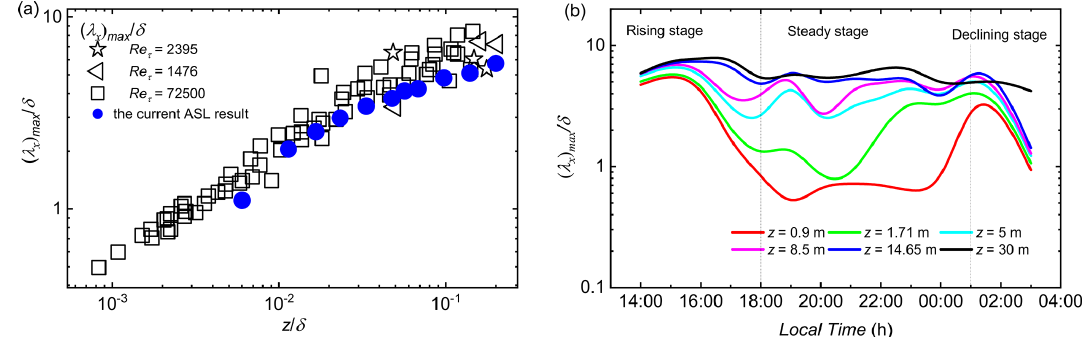
Figure 4. (a) Variation in the wavelength ( λ x ) max /δ of the lower wavenumber peak in pre-multiplied spectra with height in the steady stage (blue solid cycle). Hollow symbols are the turbulent boundary layer (TBL) results in Balakumar and Adrian (2007) ( Re τ = 1476, 2395) and Vallikivi et al. (2015) ( Re τ = 72500). (b) Evolution of ( λ x ) max /δ with time at different heights in the whole process of the sandstorm.